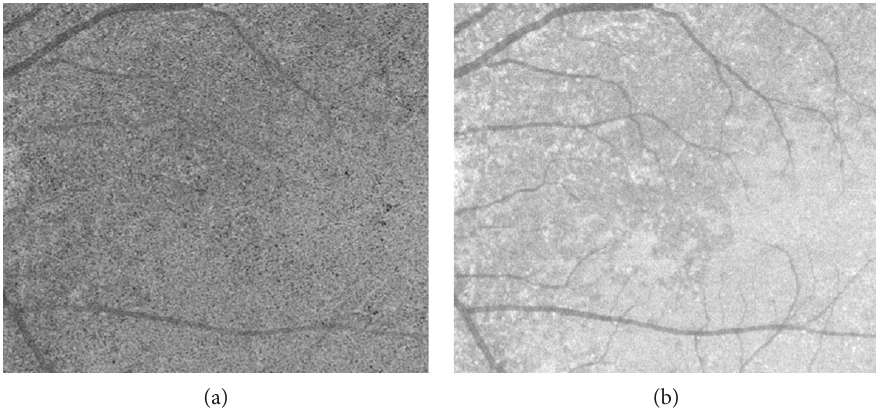
Figure 3: Increased and decreased signals in the choroidal capillaries seen on OCTA. Corresponding en face images for (a) OCTA and (b) SS- OCT. The dark area on the left in (a) and (b) indicates that the velocity of blood fl ow in the choriocapillaris is slow in the region of choroidal atrophy, compared with that in the bright area. OCTA: optical coherence tomography angiography; SS-OCT: swept-source optical coherence